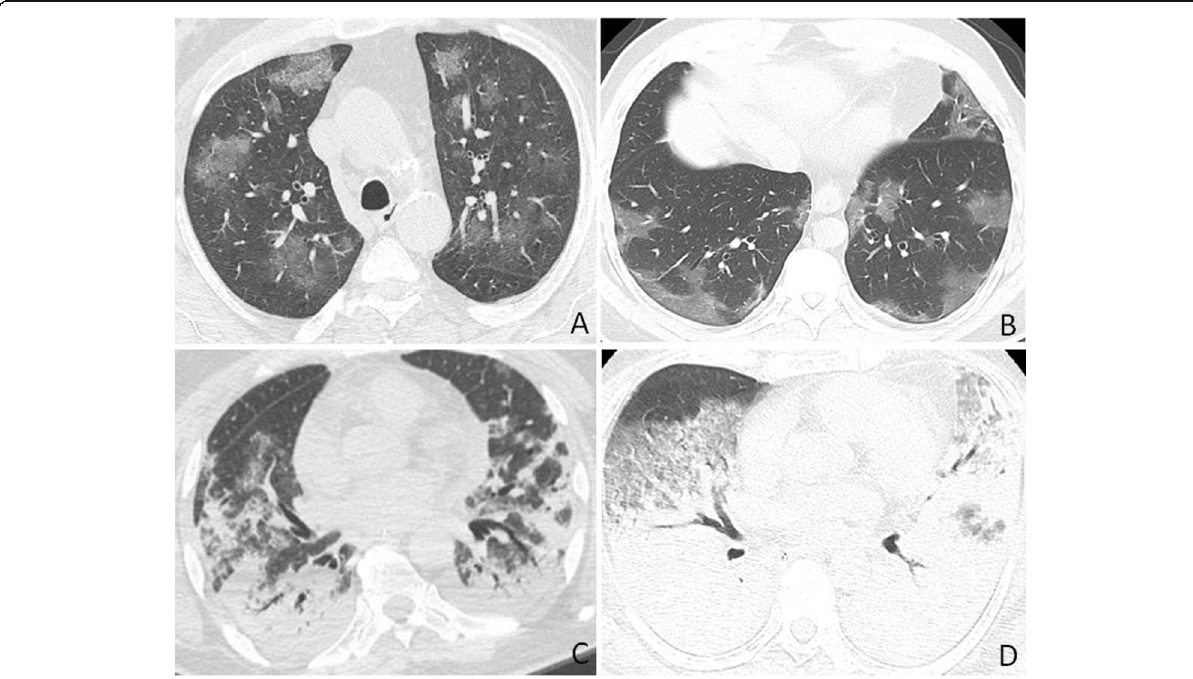
Fig. 3 COVID-19 and bacterial pneumonia misdiagnosed as COVID-19. a Axial CT image obtained from a 49-year-old man with positive PCR test for COVID-19 shows peripherally located multifocal areas of GGO and superimposed interlobular septal thickening. b Axial CT image obtained for a 38-year-old man with Klebsiella pneumonia shows peripherally located GGO as shown in ( a ). c Axial CT image obtained from a 67-year-old woman admitted to ICU with positive PCR for COVID-19 and secondary infection by Staphylococcus aureus ; axial CT shows bilateral consolidation